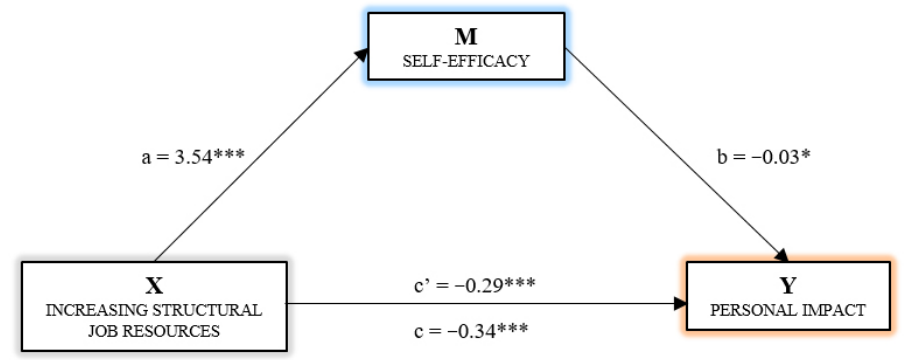
FIGURE 2. A simple mediation model of Self-efficacy on the relationship between the IStJR dimension of Job Crafting and Personal impact of burnout.